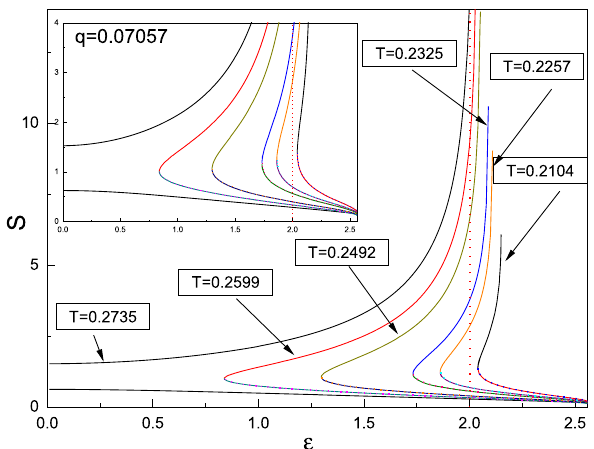
Fig. 8 The entropy as functions of boundary rotation parameter ε for T ≤ T min = 0 . 2735 with q = 0 . 07057. The black lines indicates T = T min and the red vertical dash line indicates the ε = 2